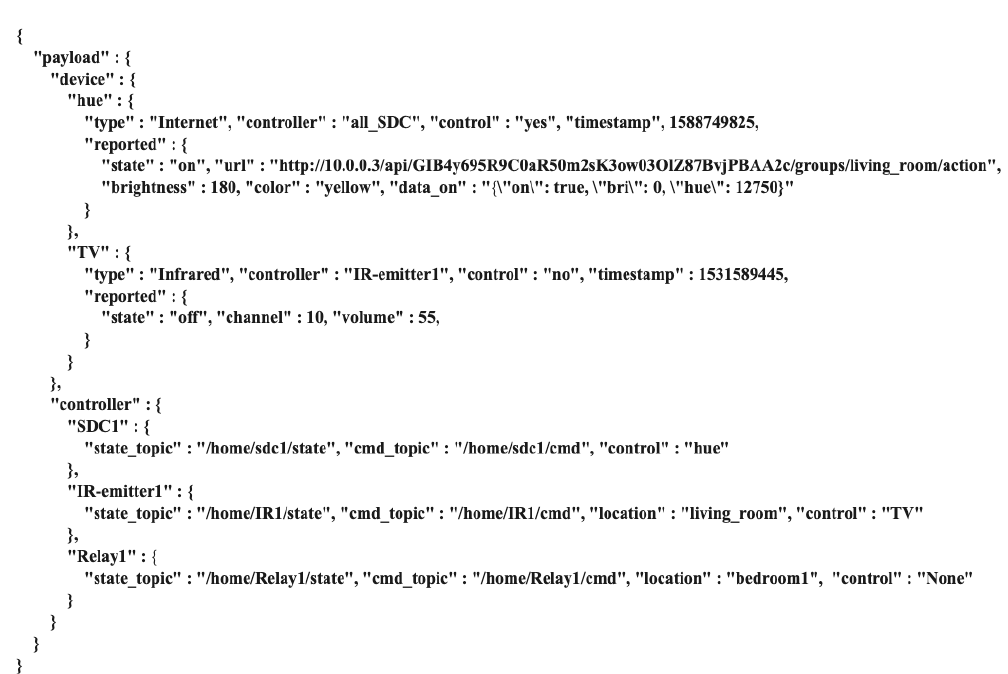
Figure 5. Device status. Figure 5. Device Figure 4. The flowchart of the analysis of user request.